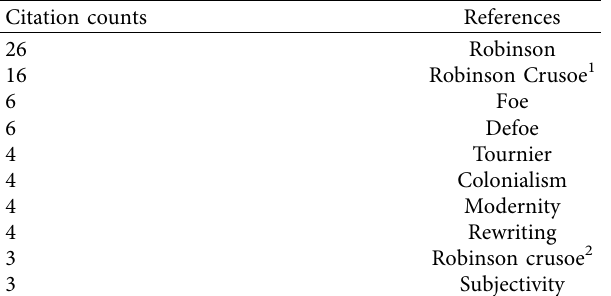
Table 10: Top 10 keywords by citation